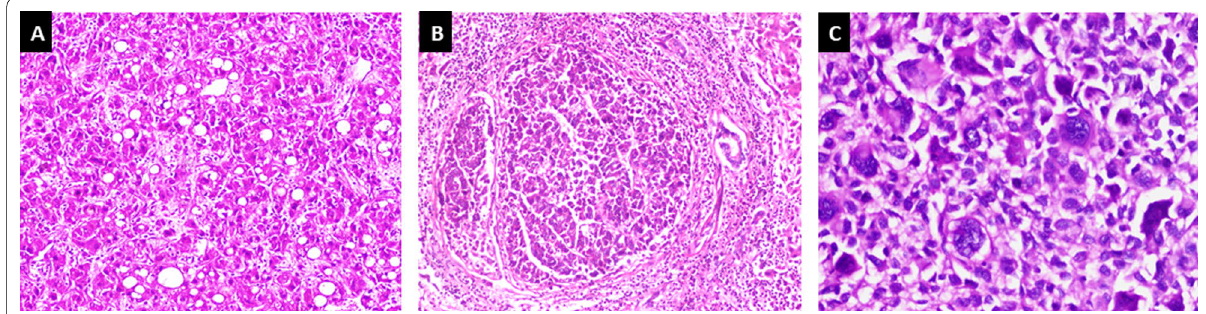
Fig. 1 Photo microscopic picture showing histological variants of hepatocellular carcinoma. A HCC showing trabecular pattern with fatty [(HE), 10] B HCC with vascular invasion stroma (HE ×